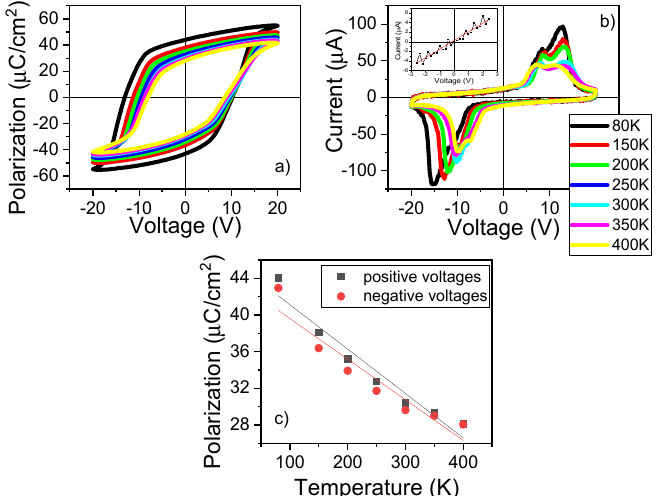
Figure 4. ( a ) The polarization-voltage characteristics recorded at different temperatures; ( b ) the current-voltage characteristics recorded at different temperatures; ( c ) the variation of the absolute value of the remnant polarization as a function of temperature (black square markers and lines are for the positive values, red circle markers and line are for the negative values). The inset in Figure 4b presents the variation of the current at low voltages and low frequency, around origin (see Section 2). The current-voltage dependence around origin is approximately linear (the Pearson’s confidence factor is around 97%) and was used to extract the electrical